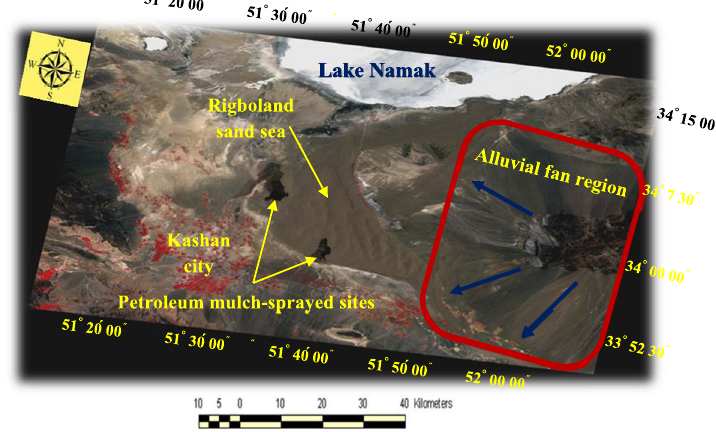
Figure 7. Landsat TM image showing alluvial fan regions (red rectangle) and direction of sand supply (blue arrow) supplying sand to the expanding eastern margins of the Rigboland sand sea. Also shown are petroleum mulch-sprayed sites marginal to Kashan city, designed to prevent sand dunes from encroaching (ENVI software version